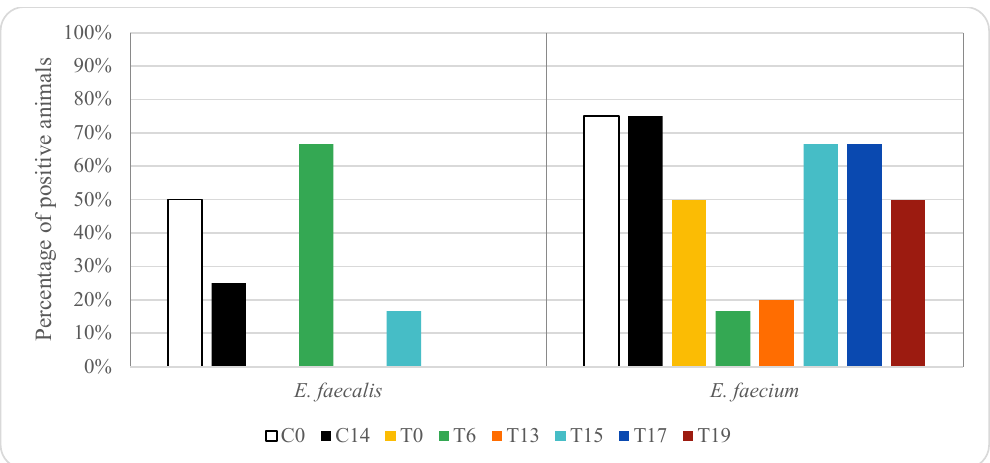
Figure 1. Effect of oxytetracycline treatment on vancomycin-resistant enterococci in pig rectal samples. For group descriptions C0, C14, T0, T6, T13, T15, T17 and T19: see Table 1.